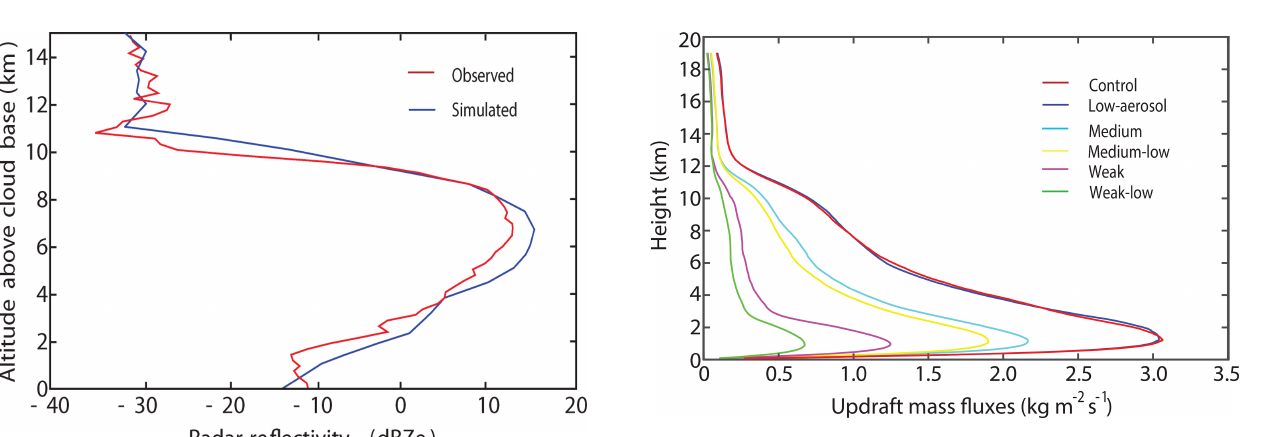
Figure 4. Vertical distributions of the average updraft mass fluxes at all altitudes in cloudy areas (i.e., where the sum of LWC and IWC is non-zero) over the simulation period between 17:00GMT on 5 August and 12:00GMT on 6